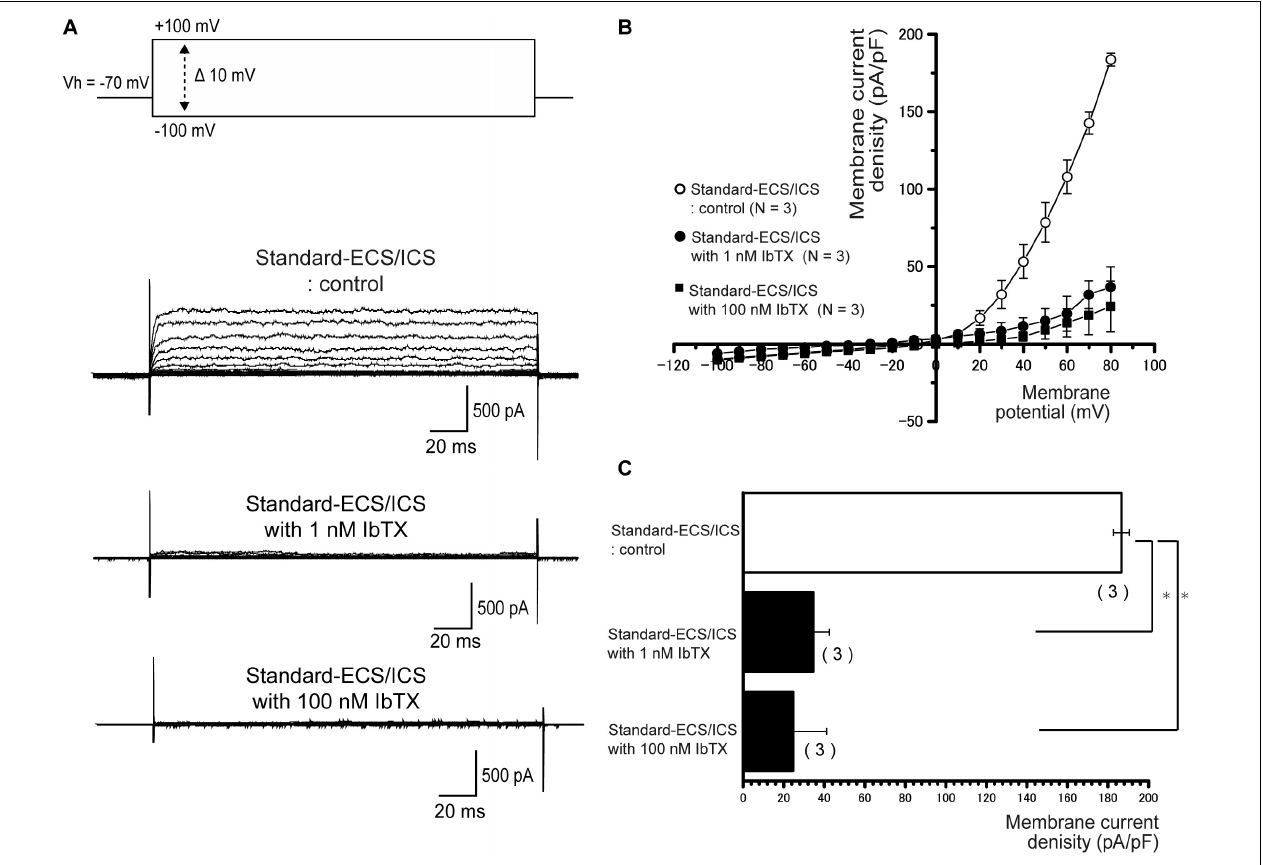
FIGURE 6 | Outward currents are sensitive to large-conductance Ca 2 + -activated K + channel antagonists . (A) Representative current traces recorded under standard-ECS/ICS conditions without (second upper traces) and with the application of 1 and 100 nM IbTX (third and fourth upper traces, respectively) are shown. Currents were evoked by applying (400 ms) voltage in 10 mV increments from –100 mV to +80 mV at a holding potential (Vh) of –70 mV (upper traces). (B) Current-voltage (I-V) relationships for the currents recorded under standard-ECS/ICS conditions without (open circles) or with the application of 1 nM IbTX (filled circles) and 100 nM IbTX (filled squares) are shown. Each point represents the mean ± SE current of three cells. (C) Summary bar graph showing current densities under standard-ECS/ICS conditions at a membrane potential of +80 mV without (upper column) or with the application of 1 nM IbTX (middle column) and 100 nM IbTX (lower column). Each column represents the mean ± SE of each three cells. Statistically significant differences are denoted by asterisks, ∗ P <